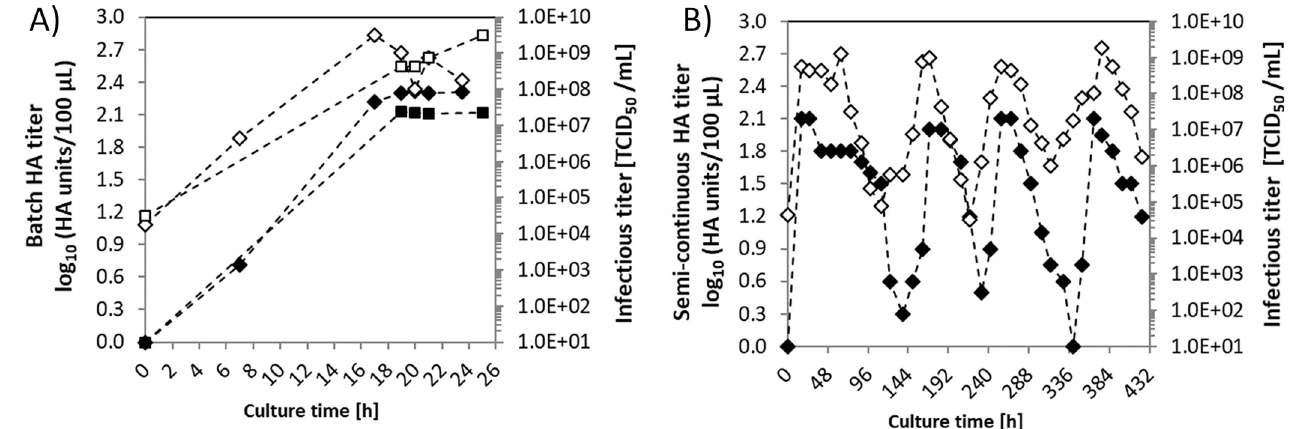
Fig 4. Influenza A/PR/8/34 virus propagation in AGE1.CR.pIX cells in batch and semi-continuous cultures. A) HA titers (closed symbols) and TCID 50 titers (open symbols) of two batch cultures (diamond and square symbols). Batch cultures were initiated with cells of the CSTR of the continuous tubular bioreactor system (see Fig 1) after termination of continuous cultivations. B) Influenza HA titers (closed diamonds) and TCID 50 titers (open symbols) of a semi-continuous culture performed in shake flasks as described previously [6].